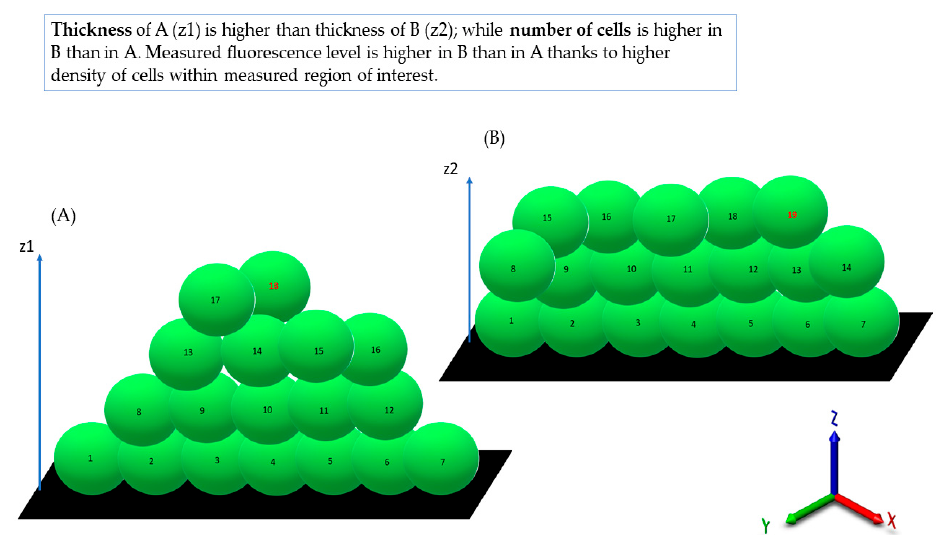
Figure 11. An attempt to explain the data presented in Table 1. Because of various cellular density between ( A ) and ( B ) parts of biofilm, the level of fluorescence of biofilm ( B ) is higher than that of biofilm ( A ), although biofilm ( A ) is thicker (4 “layers”) than biofilm ( B ), which consists of 3 “layers”. z1, z2—Z-axis showing biofilm thickness; green oval shapes—SYTO-9-dyed staphylococci emitting fluorescence; numbers in the central points of oval shapes show a higher number of cells in biofilm ( A ) in comparison to biofilm ( B ).